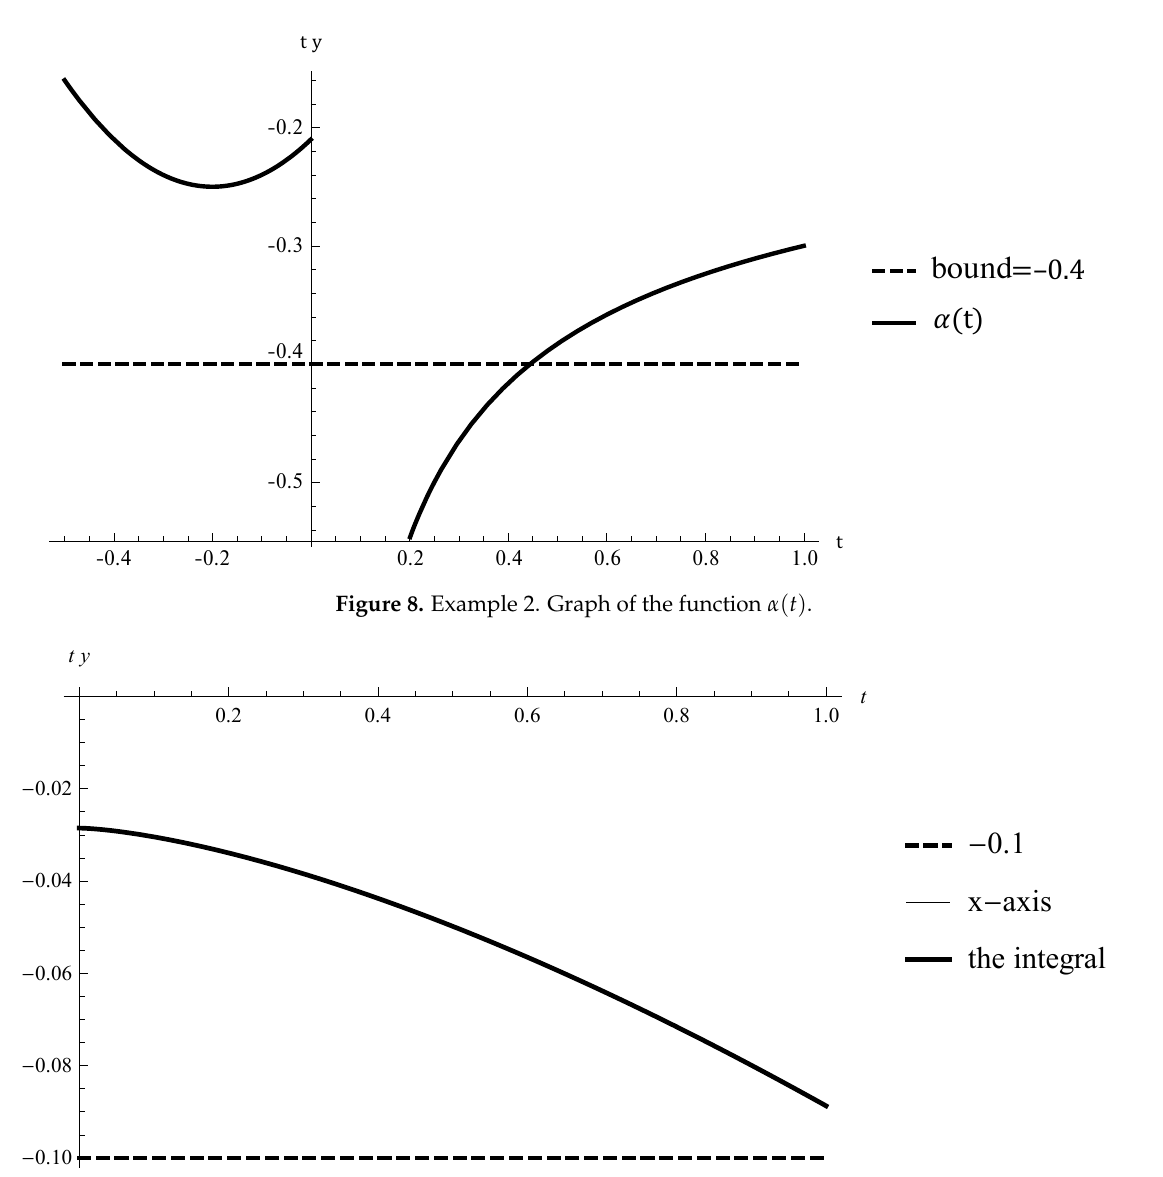
Figure 9. Example 2. Graphs of the bound − 0.1 and the